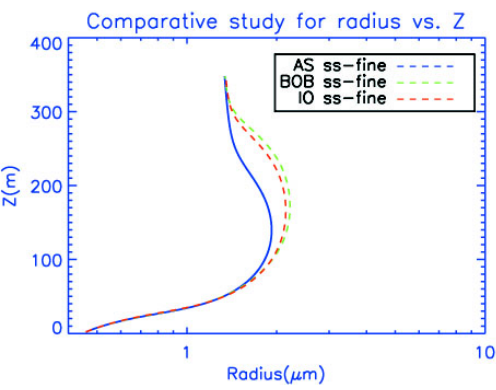
Fig. 3. Growth profile of the smallest fine mode salt